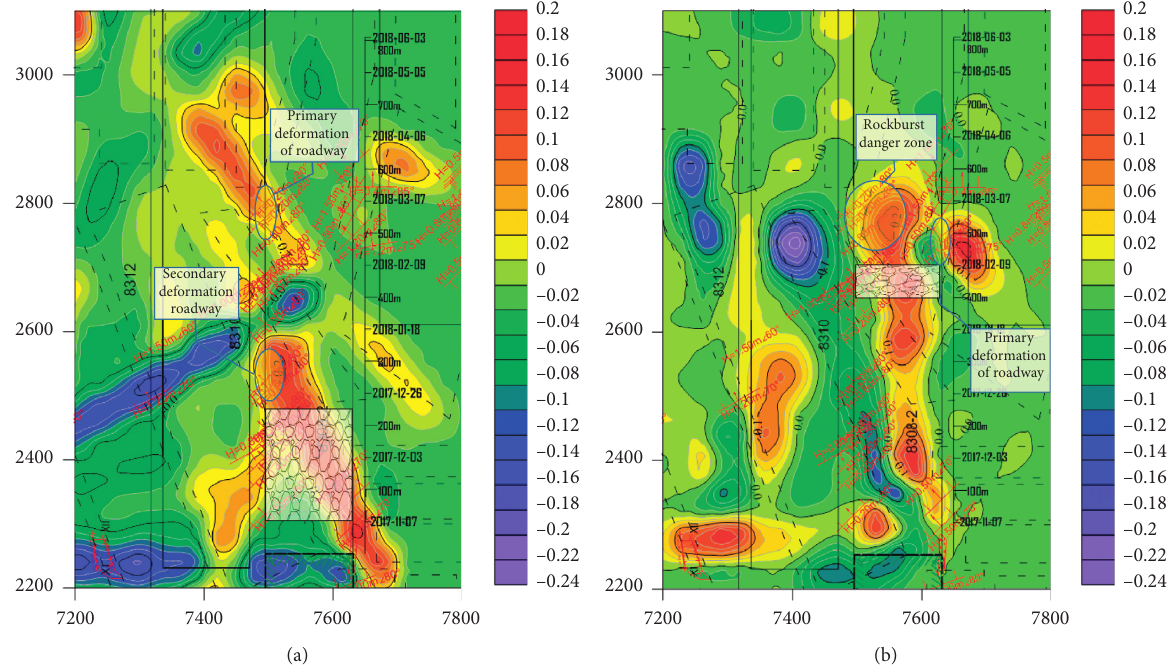
Figure 10: Distribution of abnormal coefficients of wave velocity in different mining times: (a) 2017-11-7 to 2017-12-20; (b) 2018-1-30 to 2018-2-10.